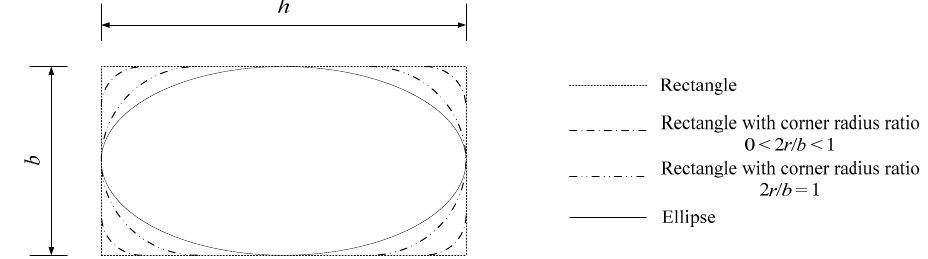
Figure 4. The details of rectangular and elliptical cross-sections.